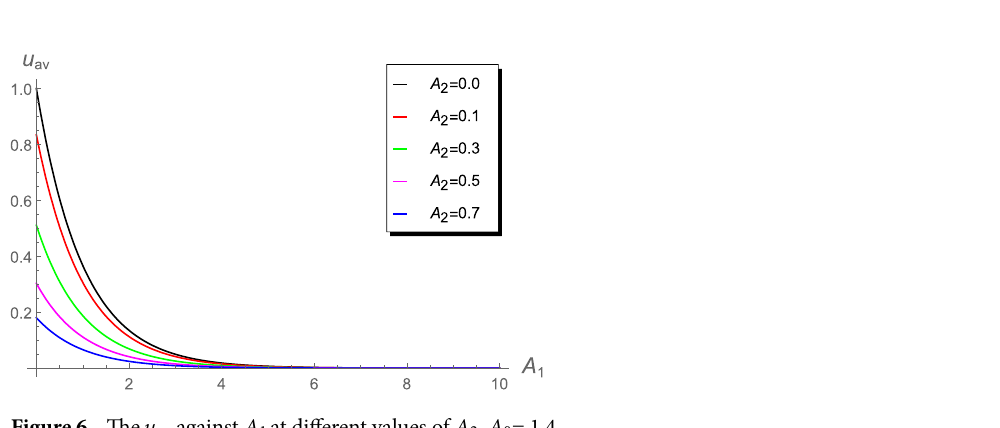
Figure 6. The u av against A 1 at different values of A 2 , A 0 =